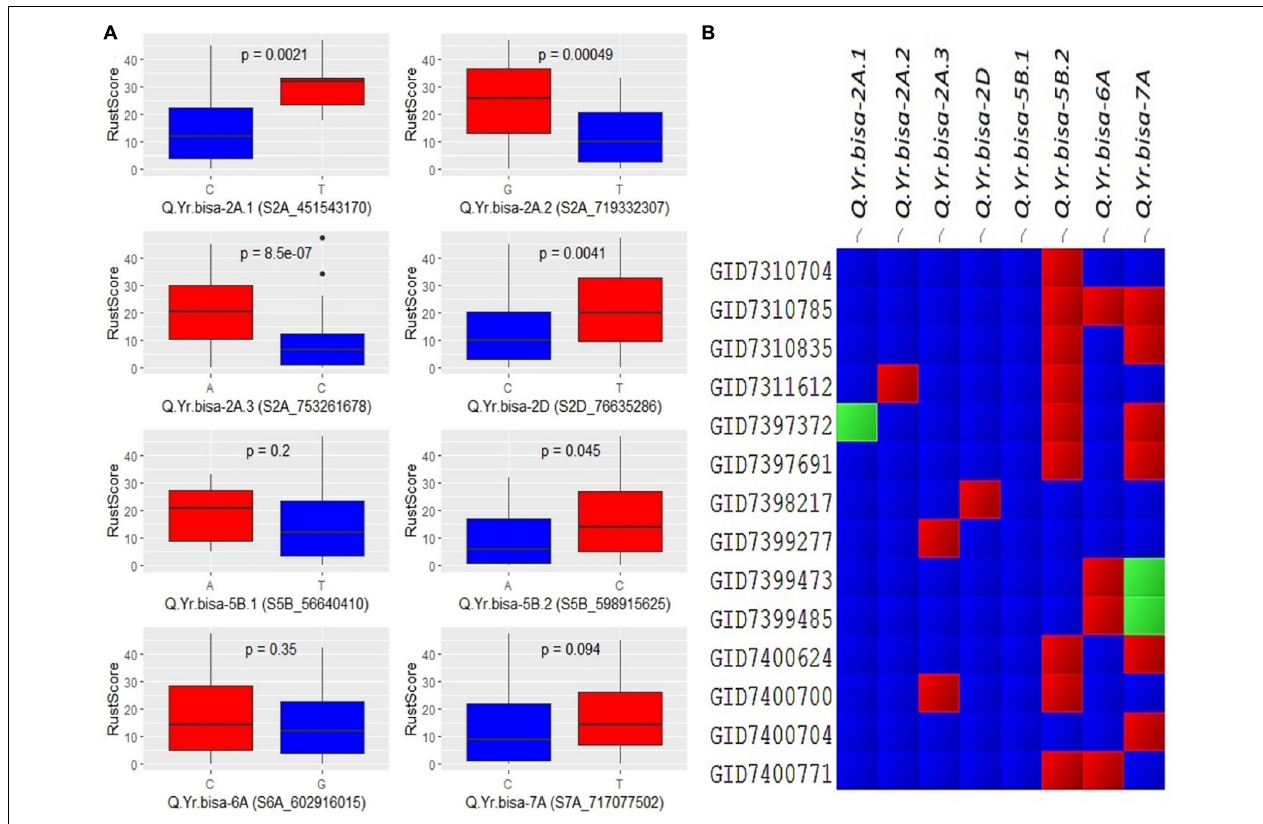
FIGURE 5 | (A) Boxplots showing the effect of phenotypic variation between the two alleles of the associated SNPs of identified QTLs for stripe rust disease score; the Kruskal–Wallis test was used to determine the significant differences between the mean values of two alleles. (B) Cell plot of the distribution of the different alleles of significant SNPs of identified QTLs in the totally resistant lines from the panel. # Blue color indicates presence of resistant allele, red color indicates presence of susceptible allele, and green color indicates presence of heterozygous allele. SNPs, single-nucleotide polymorphisms; QTLs, quantitative trait